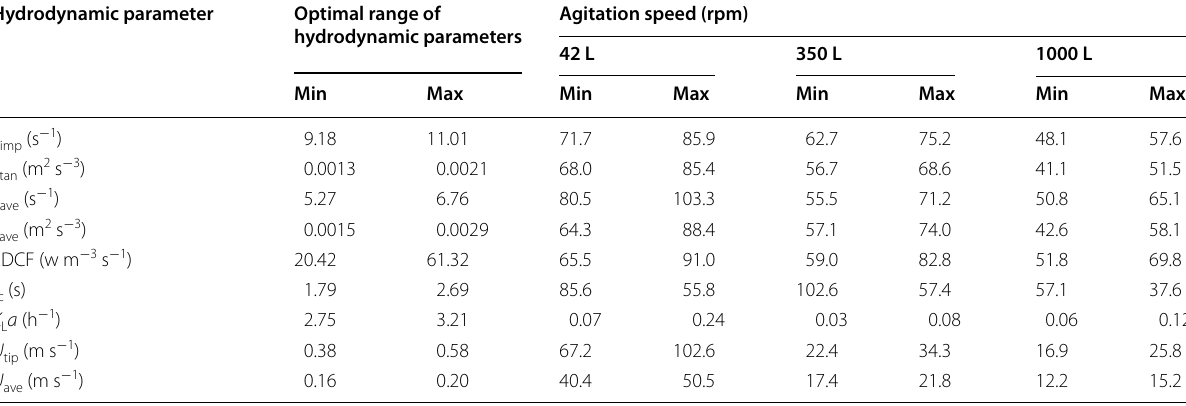
Table 4 Agitation speeds calculated for the optimal hydrodynamic parameters of BHK-21 cells cultivated in 42-, 350-, and 1000-L bioreactors